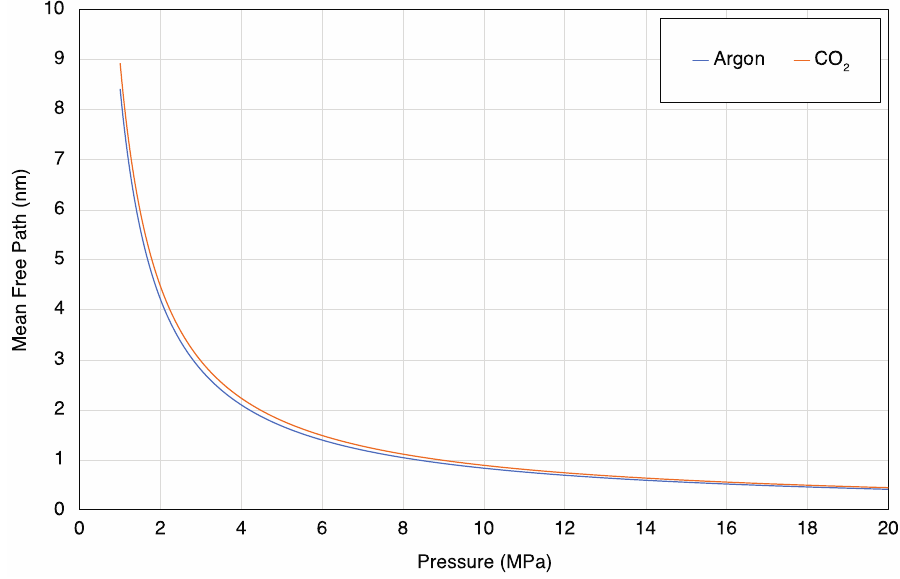
Figure 13. Mean free path for argon and CO 2 in pressures ranging from 1 to 20